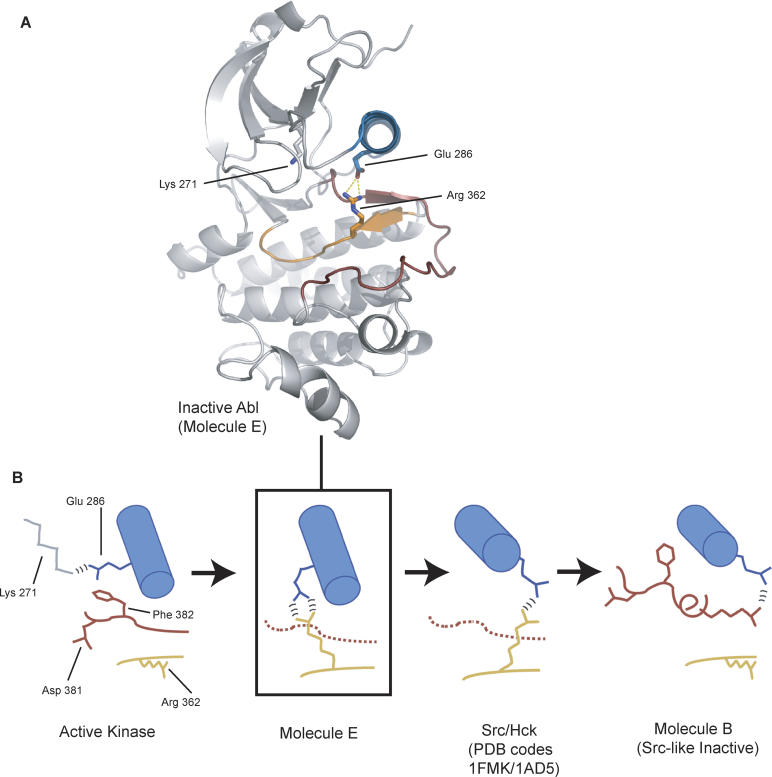
The Structure of Abl in an Intermediate Conformation Suggests a Path for the Transition between the Active and Src-Like Conformations(A) The intermediate structure of Abl (molecule E) is shown, with helix αC shown in blue, the activation loop in red, and the catalytic loop containing Arg 362 in orange.(B) The proposed pathway by which Abl makes the transition to the Src-like conformation.